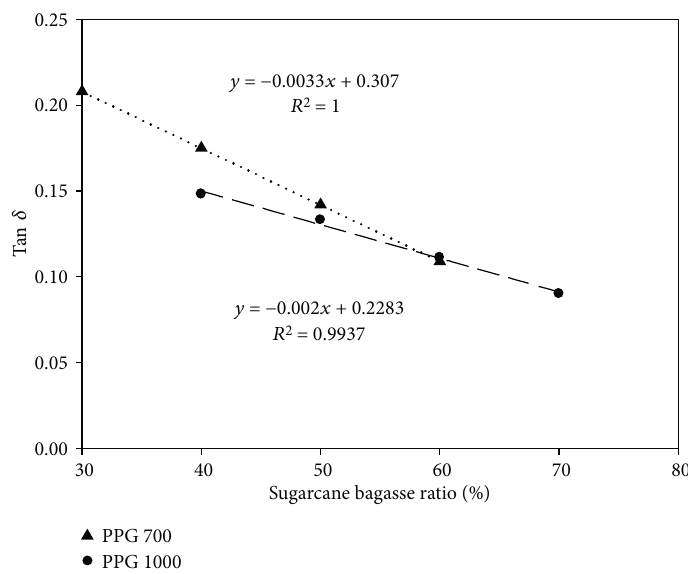
Figure 6: Linear relationship between sugarcane ratio and tan δ peak